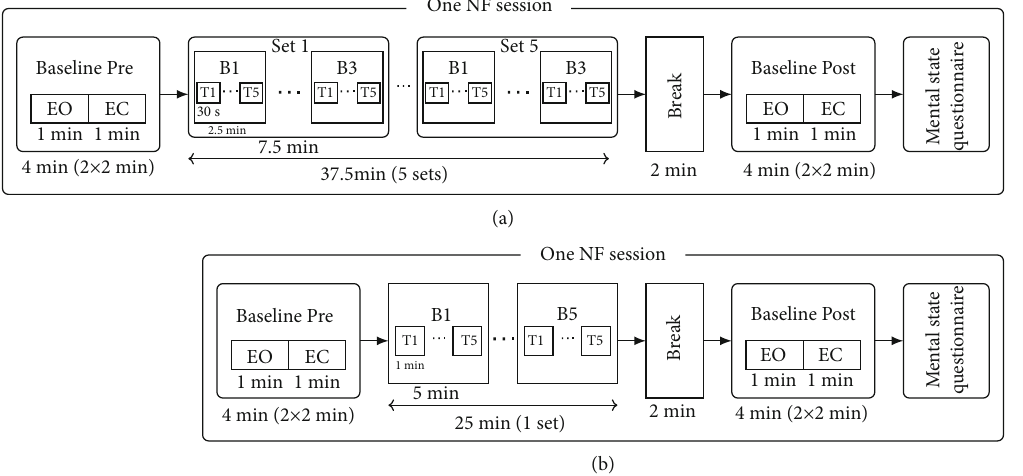
Figure 1: (a) Session diagram for the INTENSIVE group. (b) Session diagram for the SPARSE group. Each session is organized in blocks (B), which are composed of trials (T); for the baseline and pre- and post-NF, both eyes open (EO) and eyes closed (EC) were